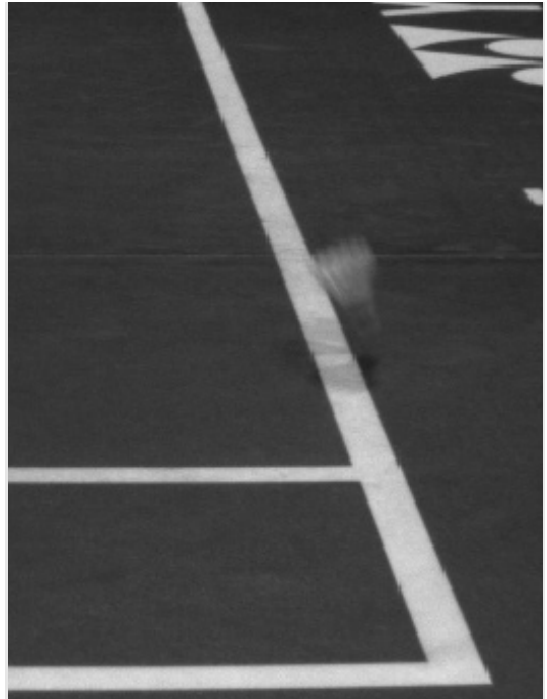
Figure 13. Before the ground hit.